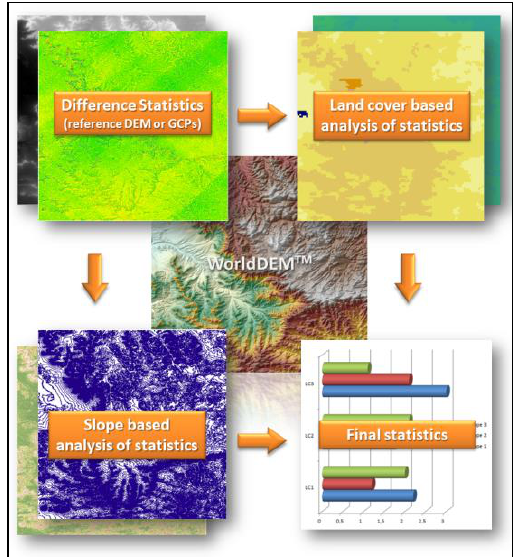
Figure 3. WorldDEM validation approach